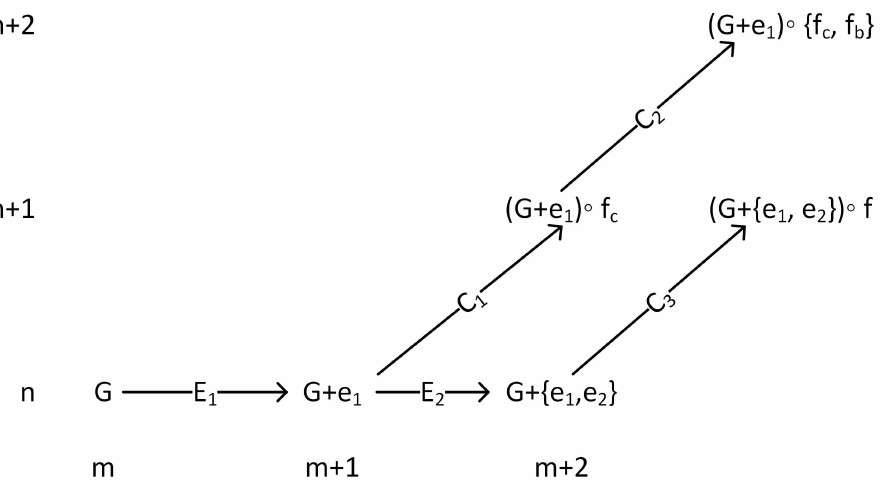
Figure 13. Minimally 3-connected graph